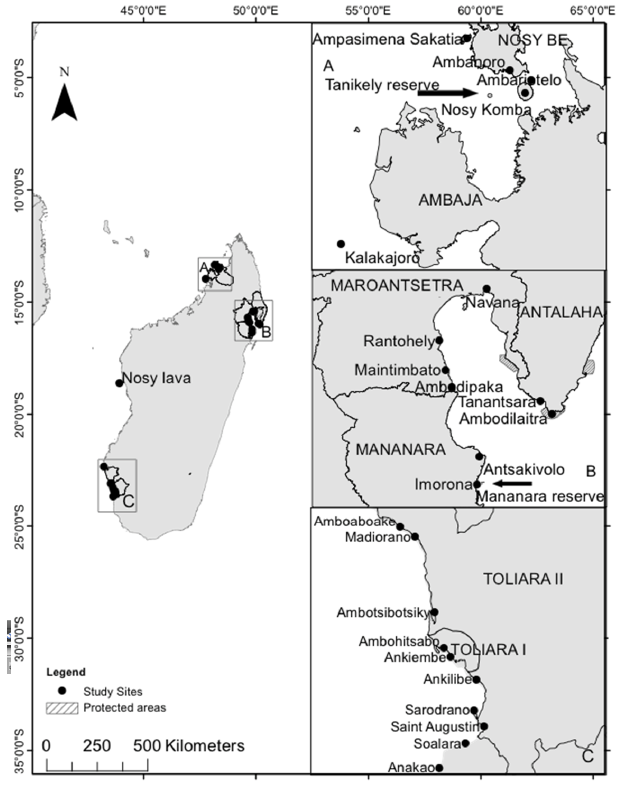
Fig. 1. Map of Madagascar indicating the locations of the fishing villages